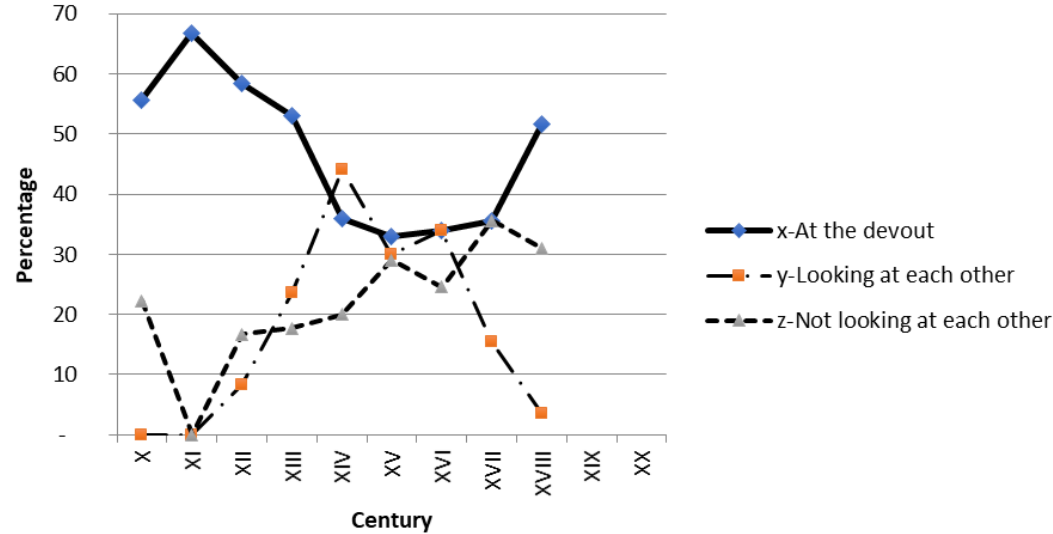
Figure 9. Mother–child gaze in representations of Mary (Spain, tenth to eighteenth centuries. Simplified). Source: Authors’ Figure 9. Mother – child gaze in representations of Mary (Spain, te nth to eighteenth centuries. Simplified). Source: Authors’ elaboration based on Trens elaboration based on Trens (1946).